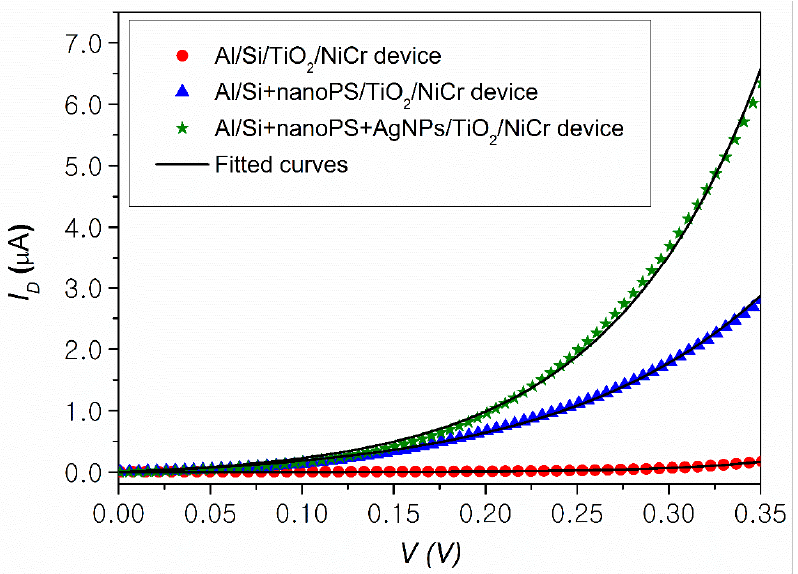
Figure 10. Experimental I - V data under forward bias and fittings to the modified ideal diode model used to extract the electrical parameters of the MIS Schottky barrier devices.